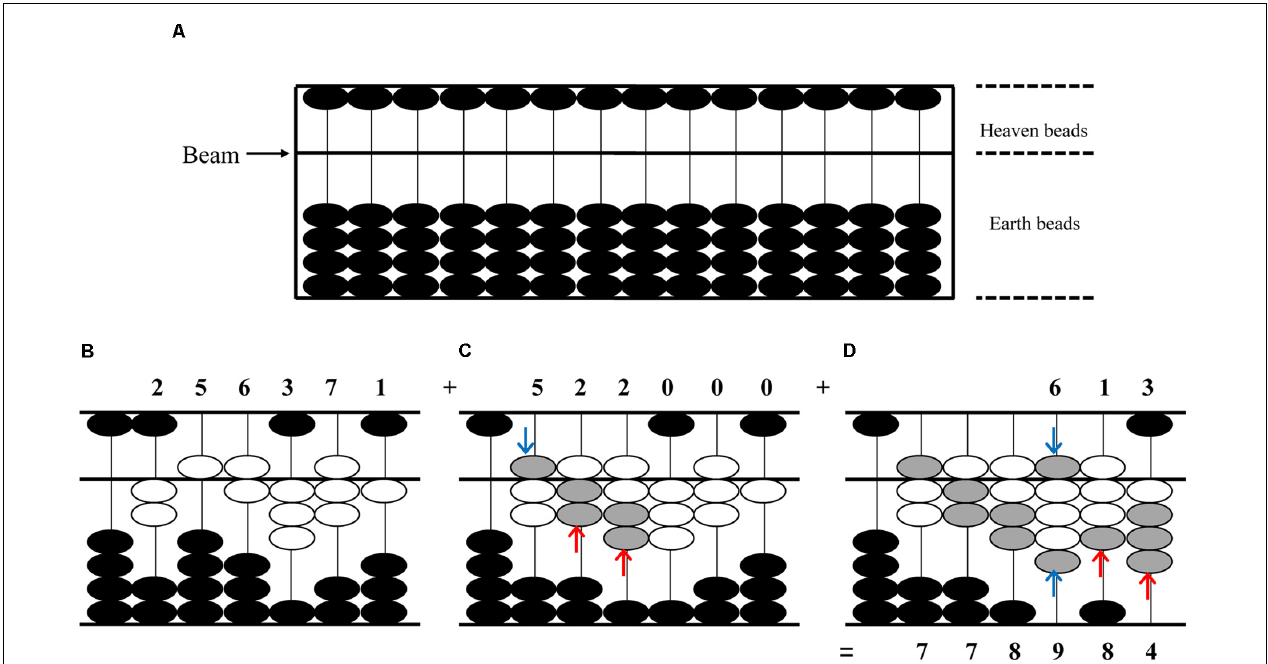
FIGURE 1 | An addition example (256371 + 522613 = 778984) on the physical abacus. (A) A physical abacus that has not been operated. Dividing the upper and lower portion of the device is a horizontal bar called a beam. The beads below the beam are called earth beads, while the beads above the beam are called heaven beads. (B) The number 256371 is represented by the white beads on the abacus. One heaven bead represents a value of five when it is pushed down, and one earth bead represents a value of one when it is pushed up. (C) When adding 256371 to 522000 for the first step, the gray beads are pushed up and down with both hands simultaneously. The blue arrows mean operations with the left hand, while the red arrows mean operations with the right hand. (D) The second step of addition is adding the intermediated result to 613. The result 778984 is represented by both the white and gray